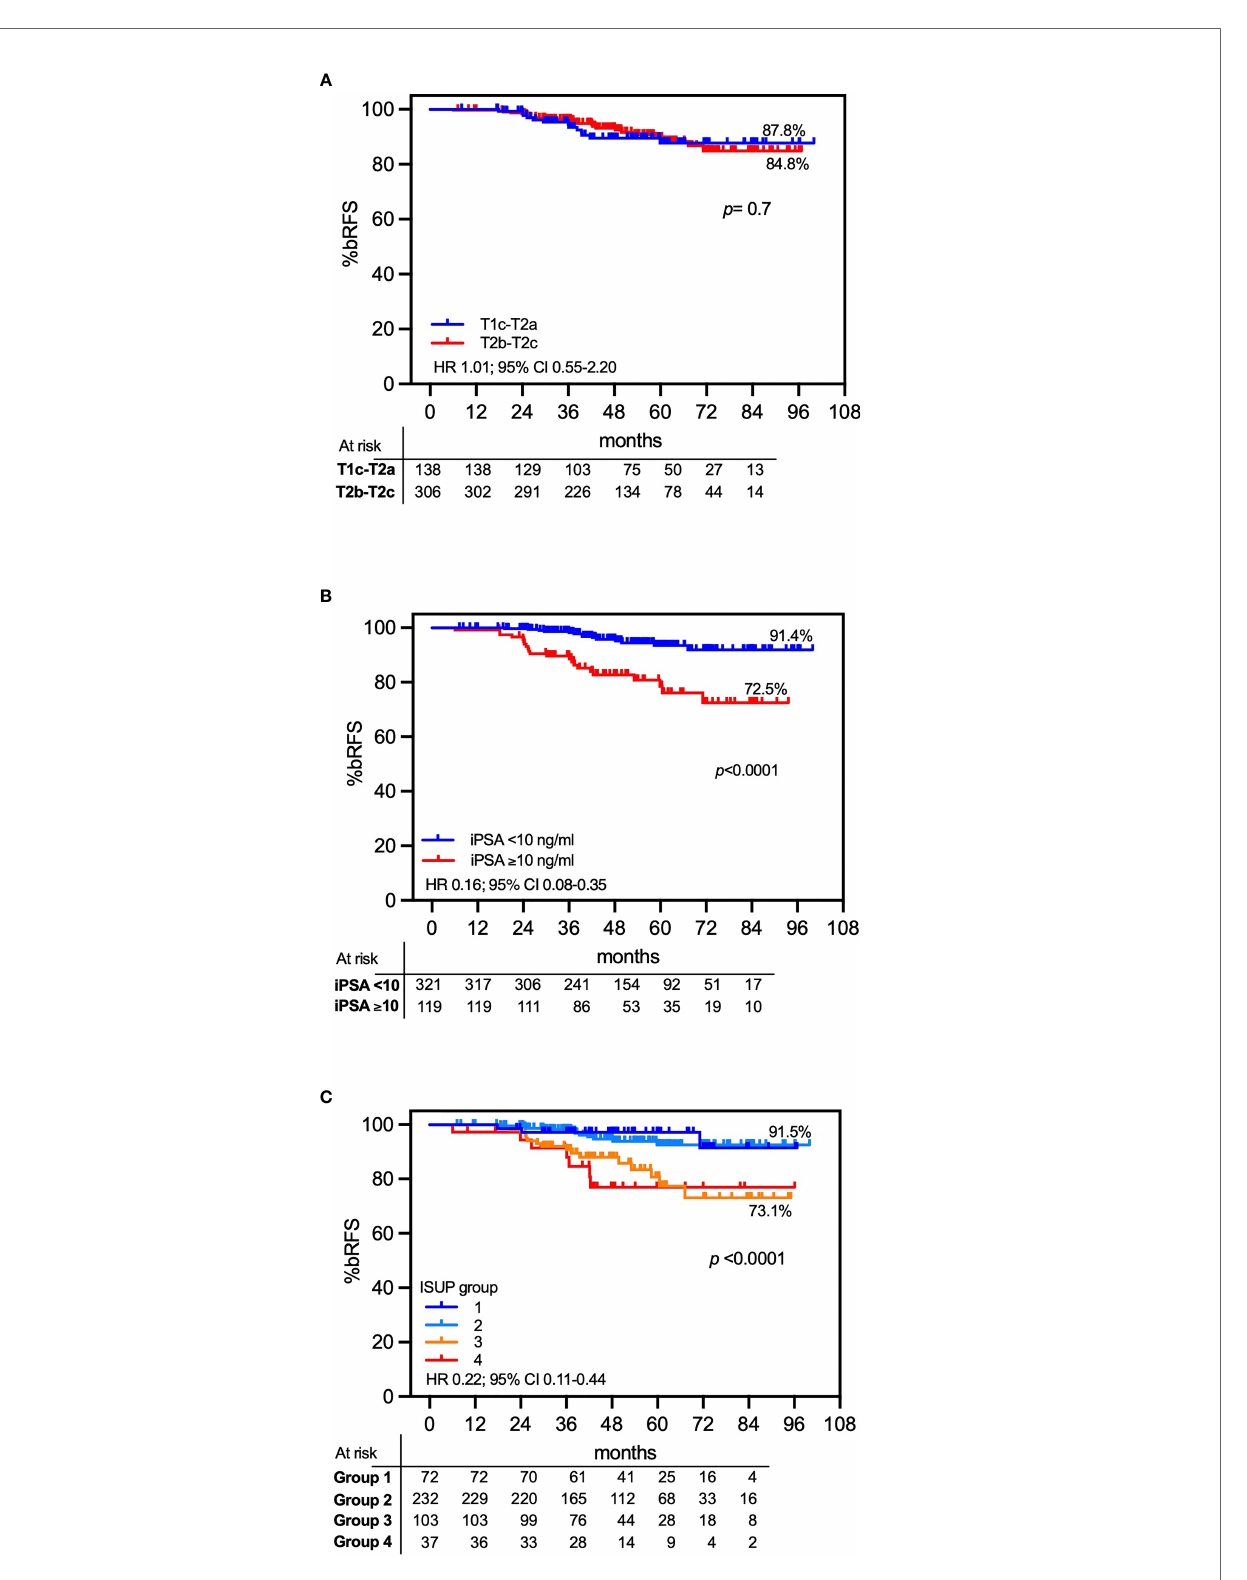
FIGURE 3 | Seven-year actuarial PSA relapse-free survival (bRFS). Actuarial bRFS is presented as a function of T stage (A) , initial PSA (B) , and biopsy ISUP grade group (C)